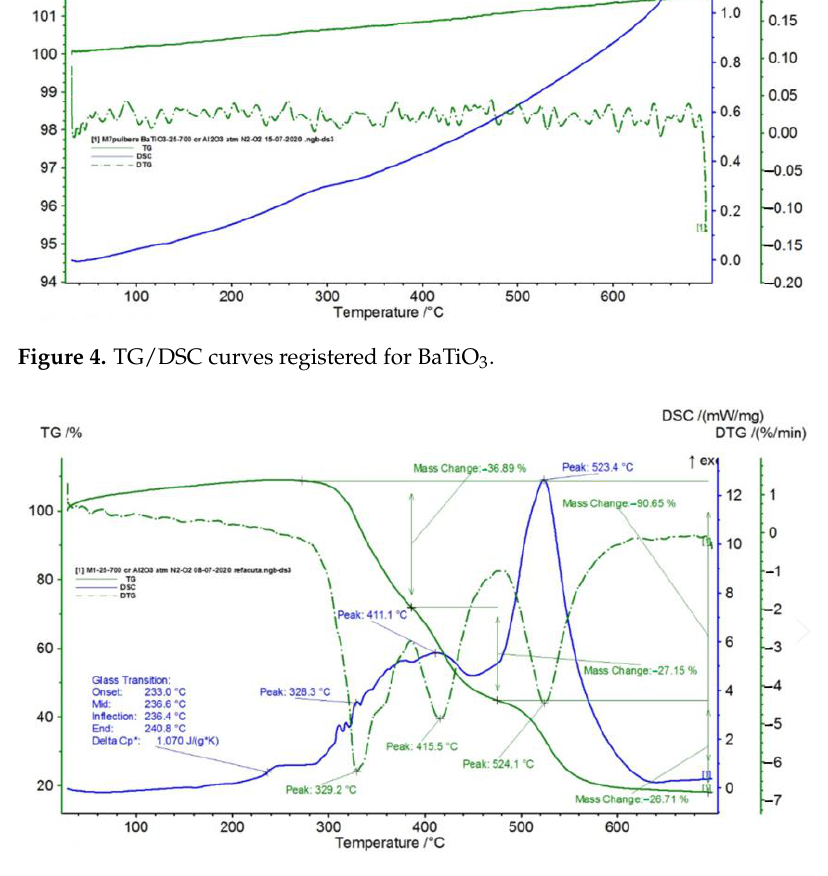
Figure 5. TG/DSC variation for sample M1.